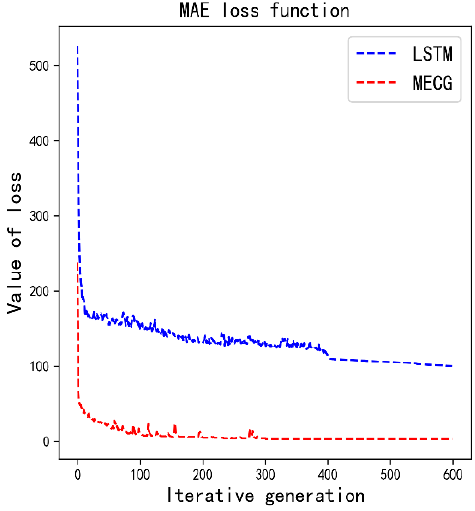
Figure 18. Convergence rate of LSTM and MECG models.